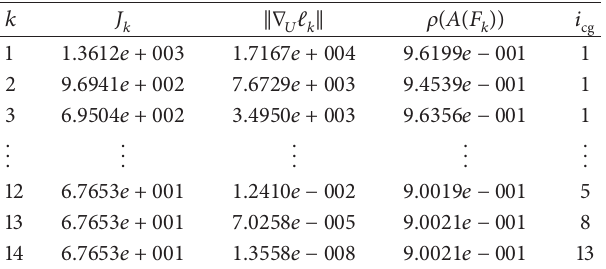
Table 3: Convergence behavior of the method DSQP for Example